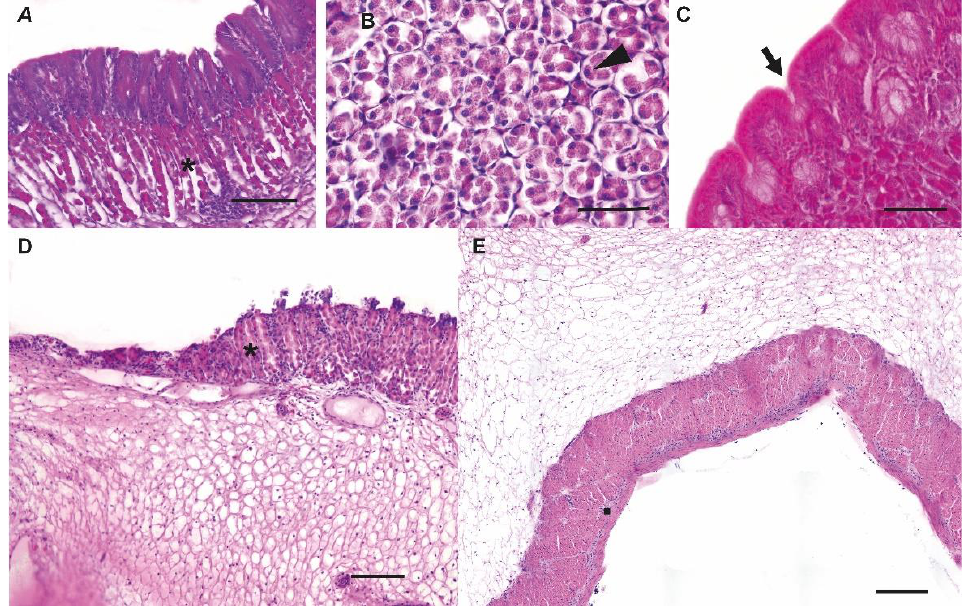
Figure 3. Histological characteristics of sagittal sections of stomach wall of Nile tilapia. ( A ): epithelial layer that coats the tubular glands (asterisk); ( B ) cross section of the tubular glands with prismatic cells (arrow head); ( C ): monolayer of cylindrical cells displaying the typical folds and delimiting the gastric pits (arrow); ( D ): transition from the esophageal to the gastric mucosa, showing tubular glands at the beginning (asterisk); ( E ): fundic zone (square putative third transversal muscle layer). Scale bars = ( A , C , D , E ): 100 µ m; ( B ): 50 µ